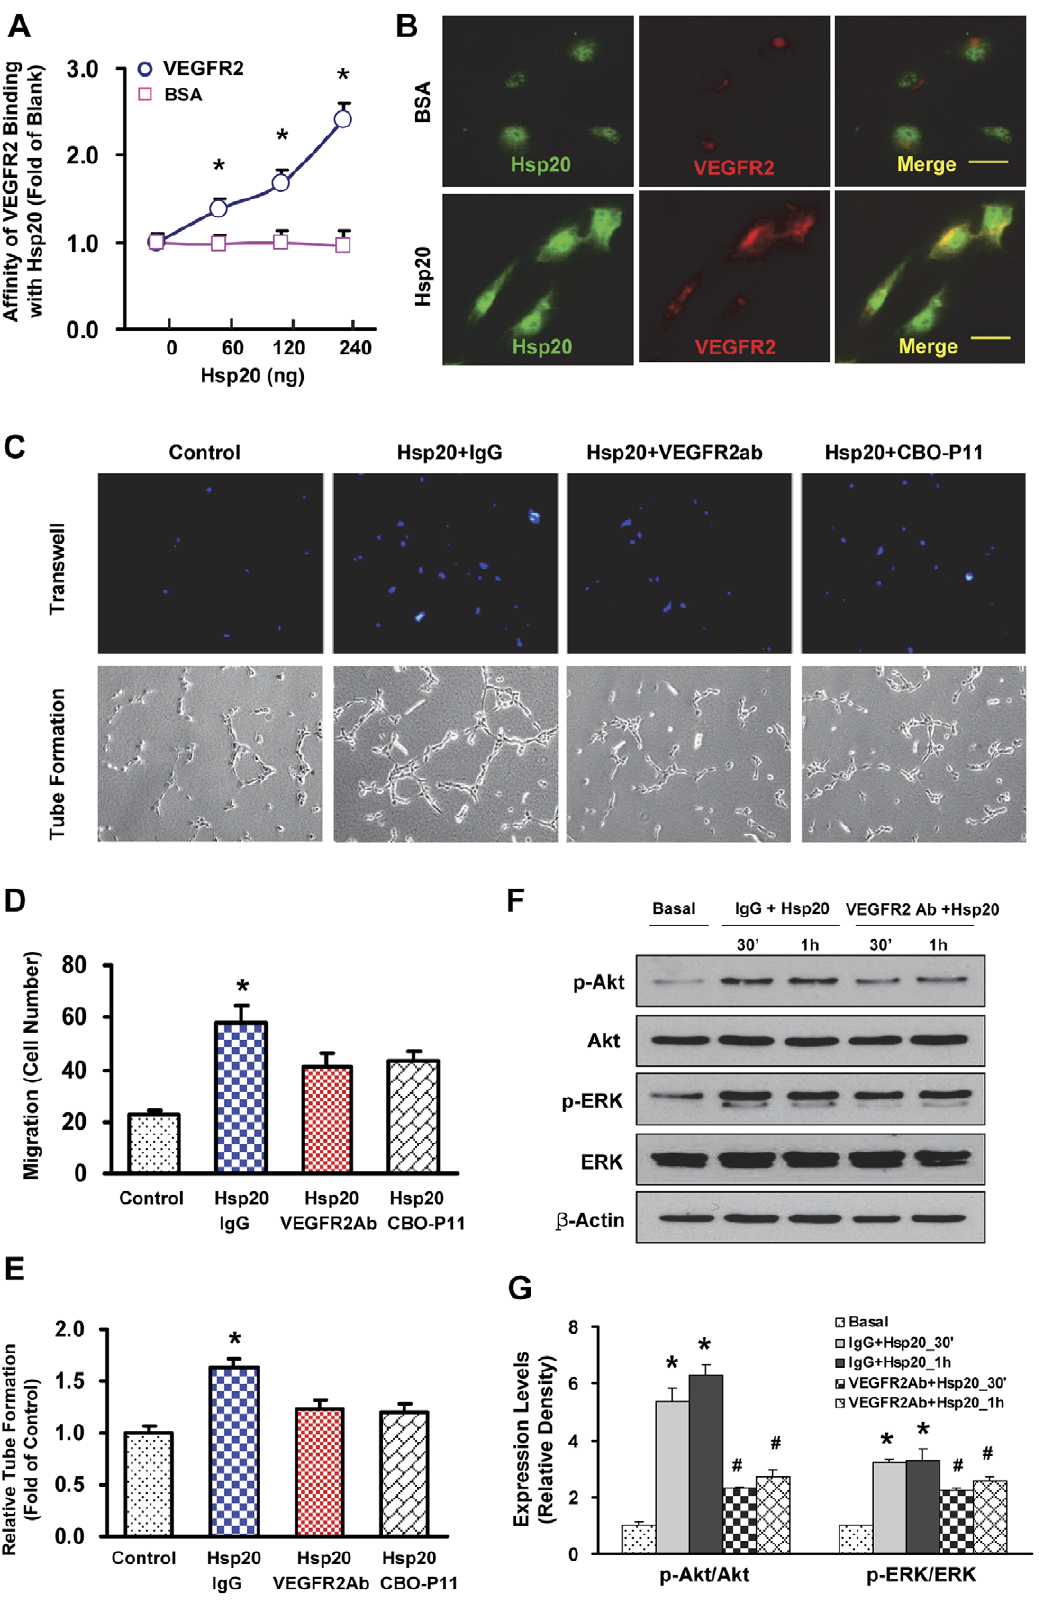
Figure 5. Extracellular Hsp20 interacts with VEGFR2 and activates its downstream signaling pathways. (A) VEGFR2 coated on a plate dose-dependently captured the Hsp20 protein, whereas BSA coated did not arrest the Hsp20 protein. (B) Recombinant human Hsp20 protein